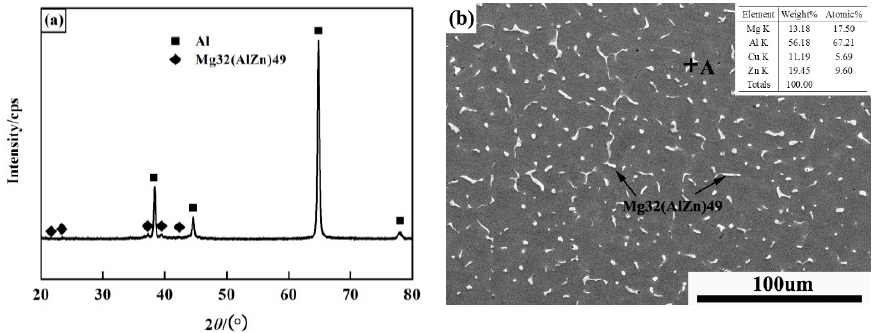
Figure 3. XRD pattern ( a ) and BSE micrograph ( b ) of the welded joint.